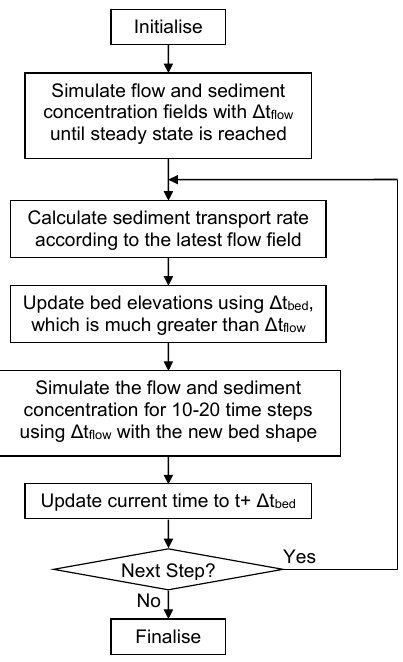
Figure 2. Flow chart of the time marching procedure.